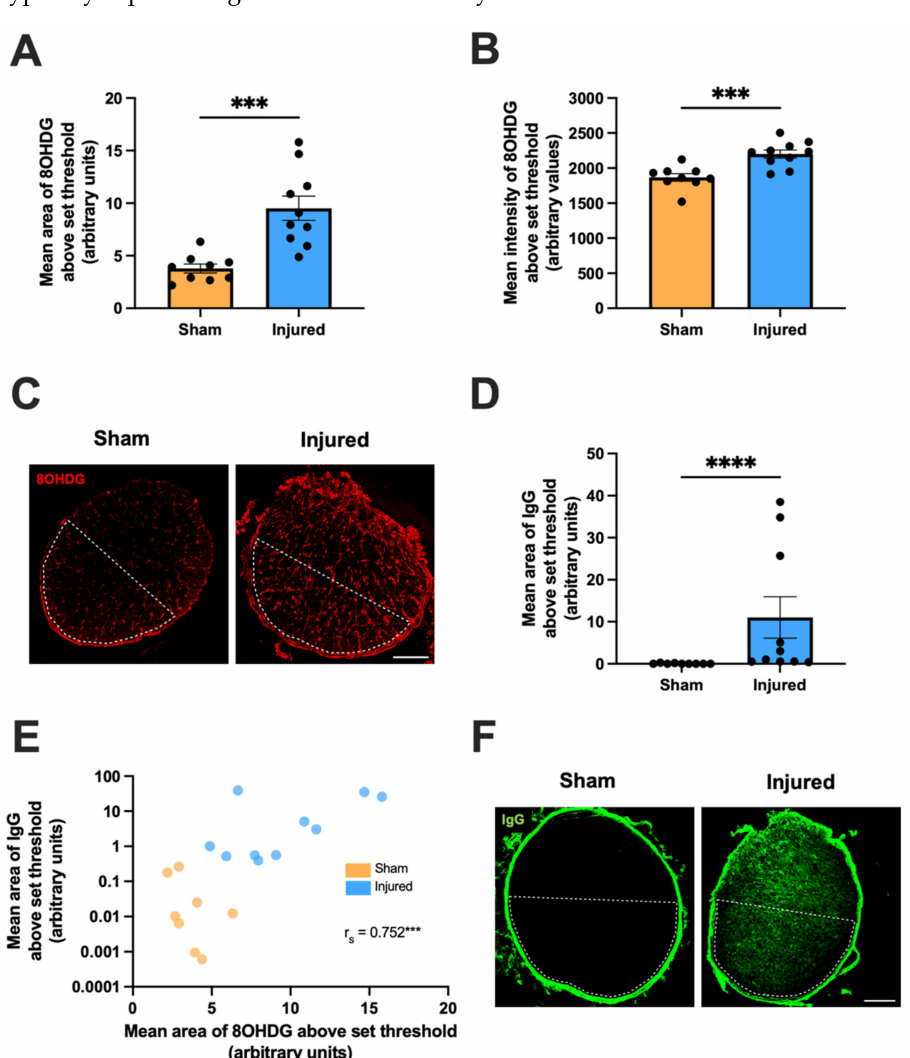
Figure 1. Effect of injury on oxidative DNA damage and BBB dysfunction within the ventral optic nerve, relative to sham injury. Area ( A ) and mean intensity ( B ) of 8OHDG immunoreactivity within the ventral optic nerve were assessed to determine the level of oxidative DNA damage. Graphs display individual data points overlaid on a bar displaying the mean ± SEM. n = 9–10 rats per group. Statistical analysis by t -tests. ( D ) Area of IgG immunointensity within the ventral nerve was assessed to determine the extent of BBB breach. Graph displays individual data points overlaid on a bar displaying the mean ± SEM. Statistical analysis by Mann-Whitney test. n = 9–10 rats per group. ( E ) The area of IgG immunointensity was correlated to the area of 8OHDG using Spearman’s correlation, with the r s value and corresponding p -value displayed on the graph. The mean area of IgG immunointensity was plotted on a log scale to best illustrate the overall relationship between IgG and 8OHDG on the scatterplot. Each data point on the graph represents an individual animal. n = 8–10 rats per group. ( C , F ) Representative images of both 8OHDG and IgG immunoreactivity in sham and injured rats are shown, scale bars = 100 µ m. Area of the ventral nerve is denoted by dotted lines. All areas above threshold measurements are presented in arbitrary units as the data have been normalized to the total area of the ventral nerve for each animal. No outliers were removed for any outcome measure. Significant differences are indicated by *** p ≤ 0.001, **** p ≤